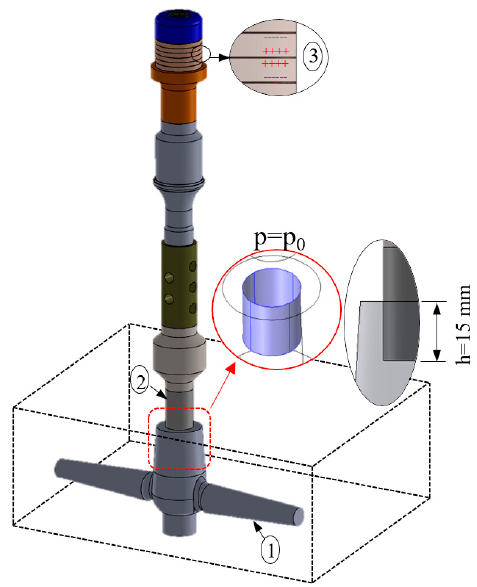
Figure 2. Geometry modeled using COMSOL Multiphysics—Acoustic Piezoeloectric (PZT) Interaction, Frequency Domain. (1) acoustic medium, (2) Ti6Al4V acoustic radiator, (3) Piezoeloectric (PZT) polarization.